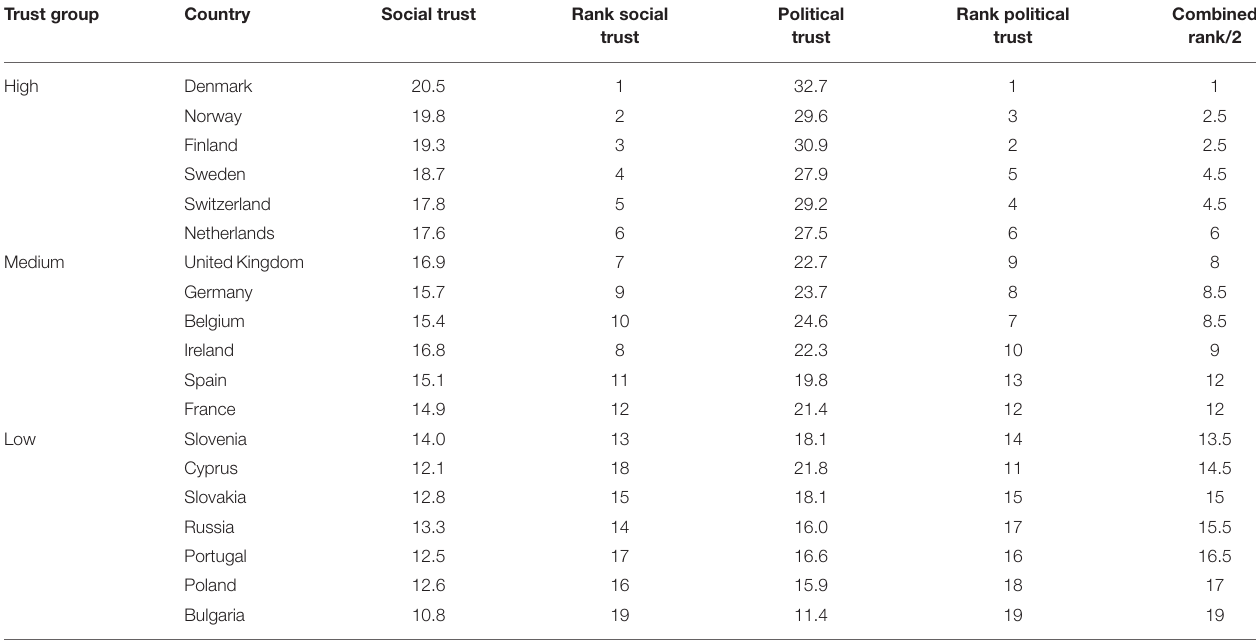
TABLE 1 | Mean weighted estimates of social and political forms of trust are used in ranking and grouping countries into three groups. Trust group Country Social trust Rank social